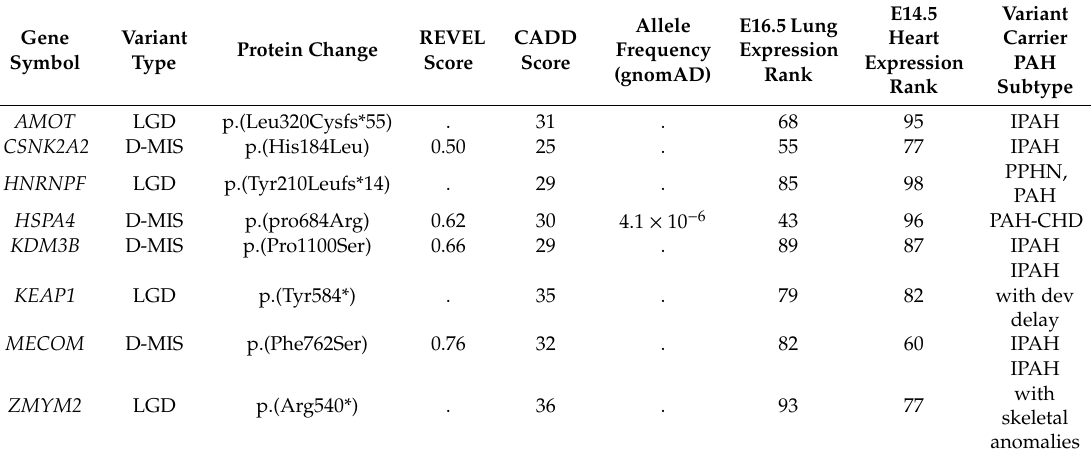
Table 4. Novel genes with rare deleterious de novo variants in pediatric-onset PAH ( n = 124 trios). Gene Variant Symbol